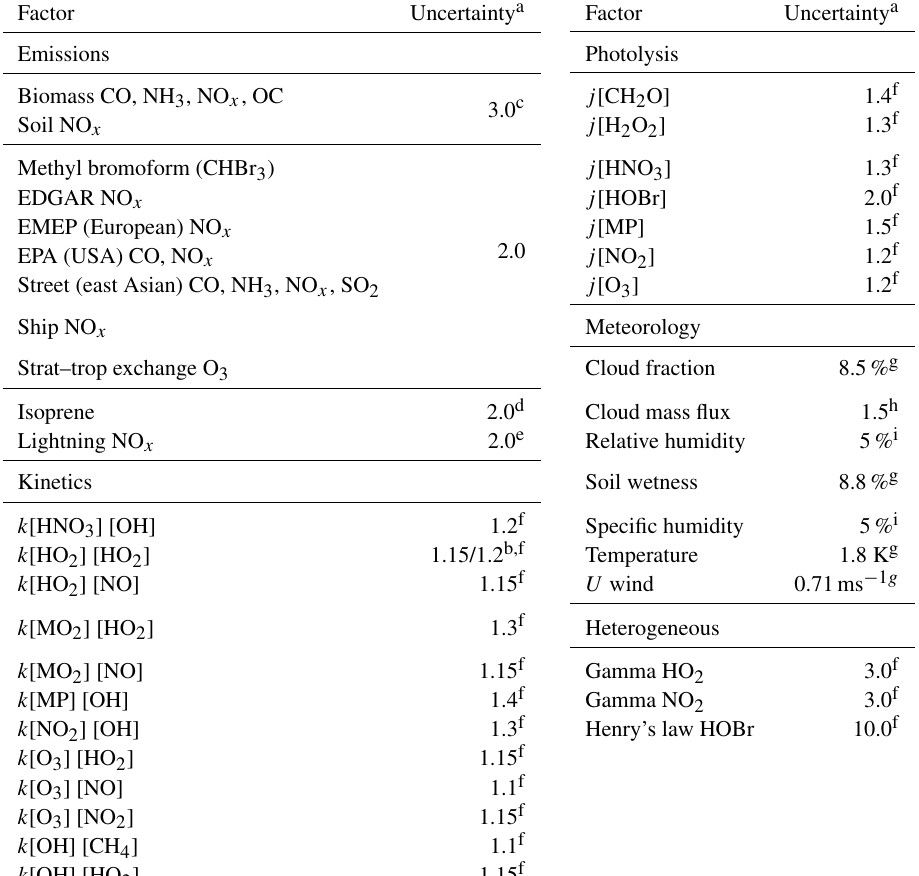
Table 2. Factors included in INTEX-B RS-HDMR analysis and their respective uncertainties. OC is organic carbon, MP is methyl hydroper- oxide, and MO 2 is methyl peroxy radical. Uncertainties are expressed as multiplicative factors, except as noted in meteorological